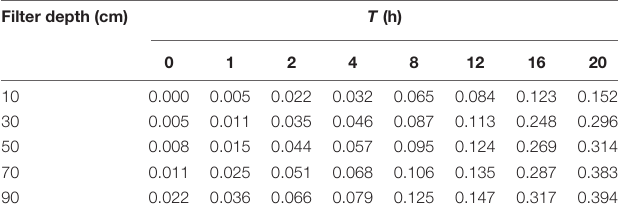
Frontiers in Microbiology |